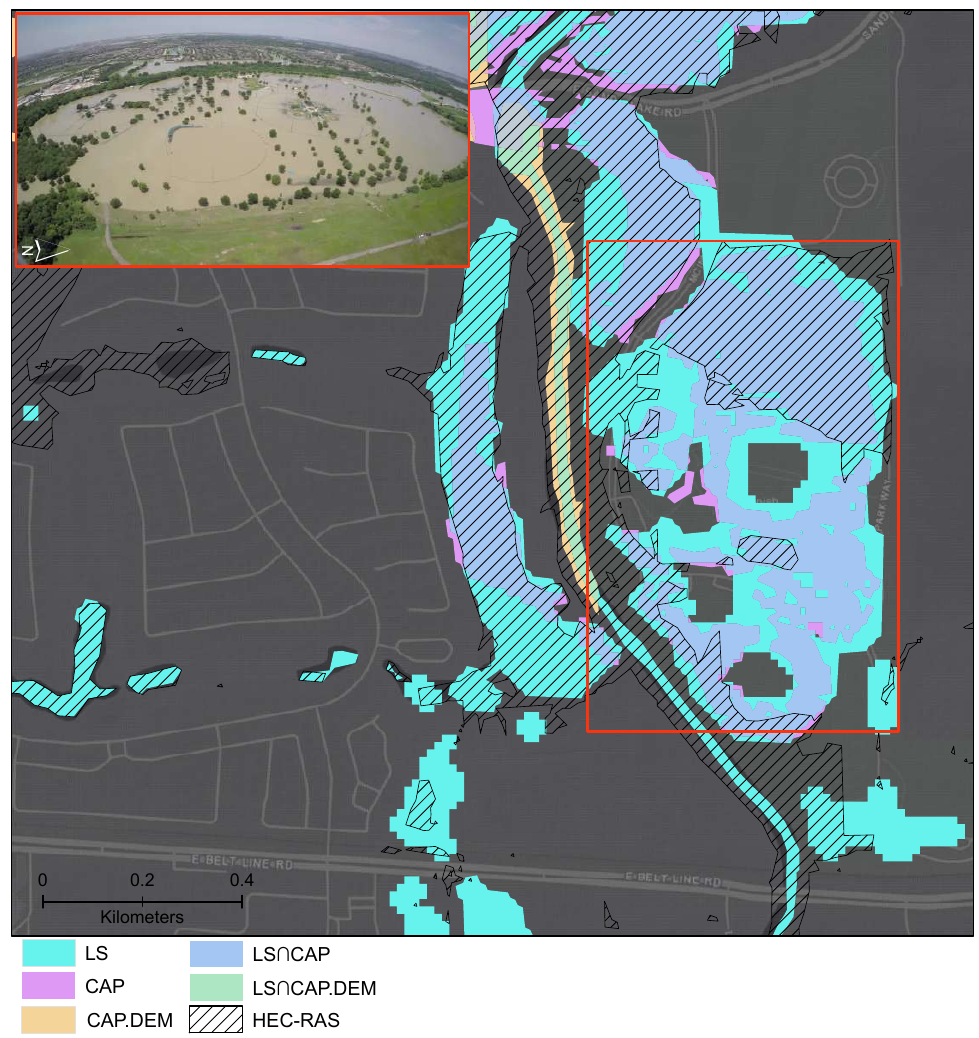
Figure 15. Flood inundation for 3 June 2015 estimated by MOP and HEC-RAS. The image in the top left corner shows the condition of the area at the time the UAV recording was